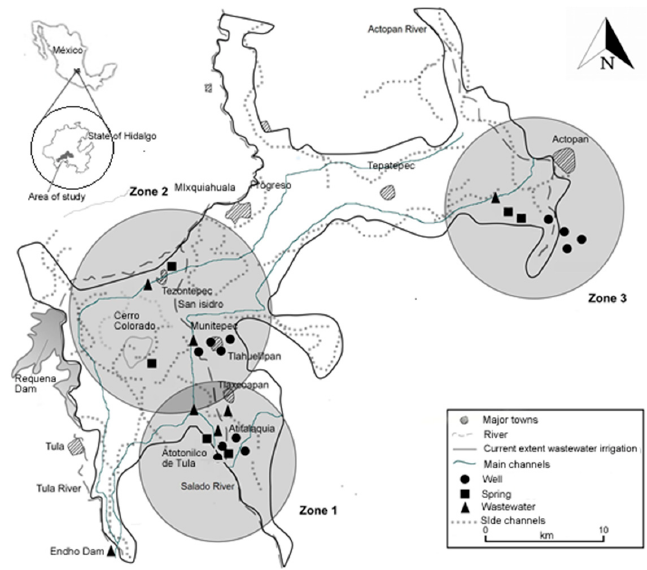
Figure 2. Location of sampling points according to the study area. (Source: “Grupo Tratamiento y Reúso del Agua”).